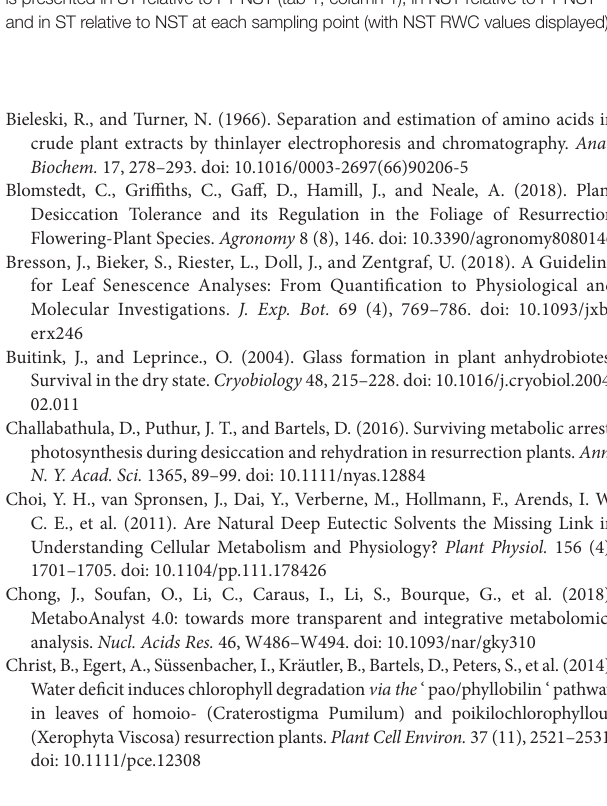
SUPPLeMeNTARY FigURe 2 | changes in amino acid accumulation during desiccation. Log2 transformed and pareto scaled normalized peak area of early-accumulating (60% RWC in NST) and late-accumulating (AD in NST) amino acids, detected by GC-MS. Error bars indicate standard deviation. SUPPLeMeNTARY FigURe 3 | Changes in amino acid accumulation during desiccation (continued). Log2 transformed and pareto scaled normalized peak area of amino acids diminished in NST relative to FT NST and lysine (peaked at 35% RWC), detected by GC-MS. Error bars indicate standard deviation. SUPPLeMeNTARY FigURe 4 | Changes in sugar accumulation during dehydration and rehydration. Log2 transformed and pareto scaled normalized peak area of sugars and sugar alcohols detected by GC-MS. Error bars indicate standard deviation. SUPPLeMeNTARY FigURe 5 | Changes in organic acid and anti-oxidant accumulation during dehydration and rehydration Log2 transformed and pareto scaled normalized peak area of organic acids and anti-oxidants detected by GC-MS. Error bars indicate standard deviation. SUPPLeMeNTARY FigURe 6 | Changes in uncategorized compound accumulation during dehydration and rehydration. Log2 transformed and pareto scaled normalized peak area of uncategorised compounds detected by GC-MS. Error bars indicate standard deviation. SUPPLeMeNTARY FigURe 7 | Transmission electron micrographs of mesophyll during rehydration in ST. 48h RH ST (A-C) and 72h RH ST (D-F). SUPPLeMeNTARY TABLe 1 | statistical test results for models in Supplementary figure 1. Significance codes: 0 ‘***’ 0,001 ‘**’ 0,01 ‘*’ 0,05 ‘.’ 0,1. SUPPLeMeNTARY DATA SeT 1 | Ribitol-normalised metabolite peak area. Data is presented in ST relative to FT NST (tab 1, column 1), in NST relative to FT NST and in ST relative to NST at each sampling point (with NST RWC values